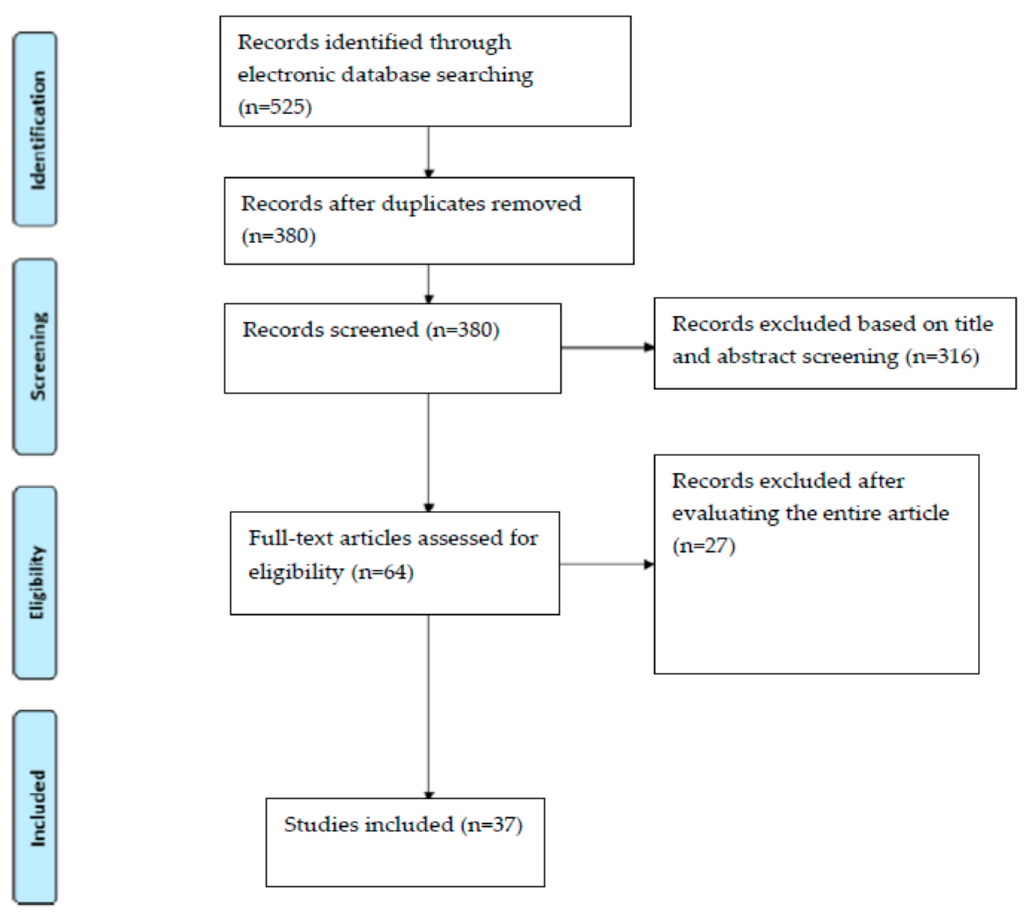
Figure 2. Selection process for the studies included (following PRISMA Statement) [21]. Table 2. Studies included in the review.